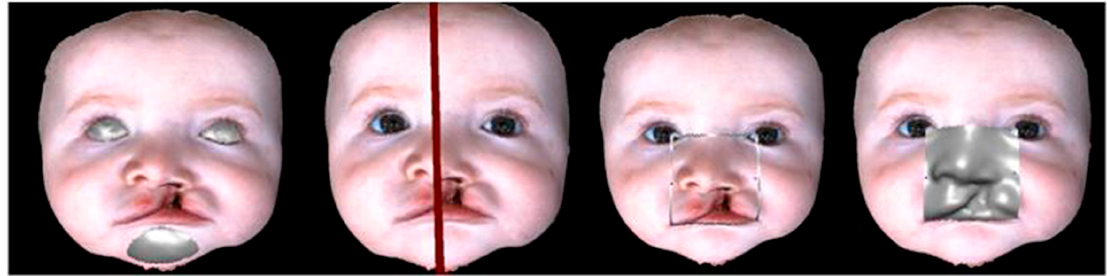
Figure 2. The digital workflow in a sequence shows: a selection of the symmetry areas; creation of the symmetry plan; delimitation of the area to be analyzed; and the overlap of a mirrored hemiface.